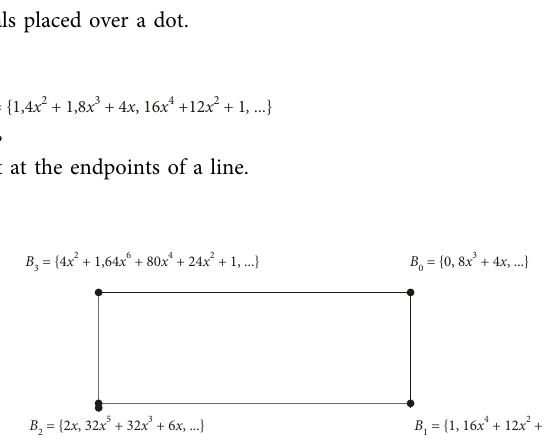
Figure 1: Pell polynomials placed over a dot.